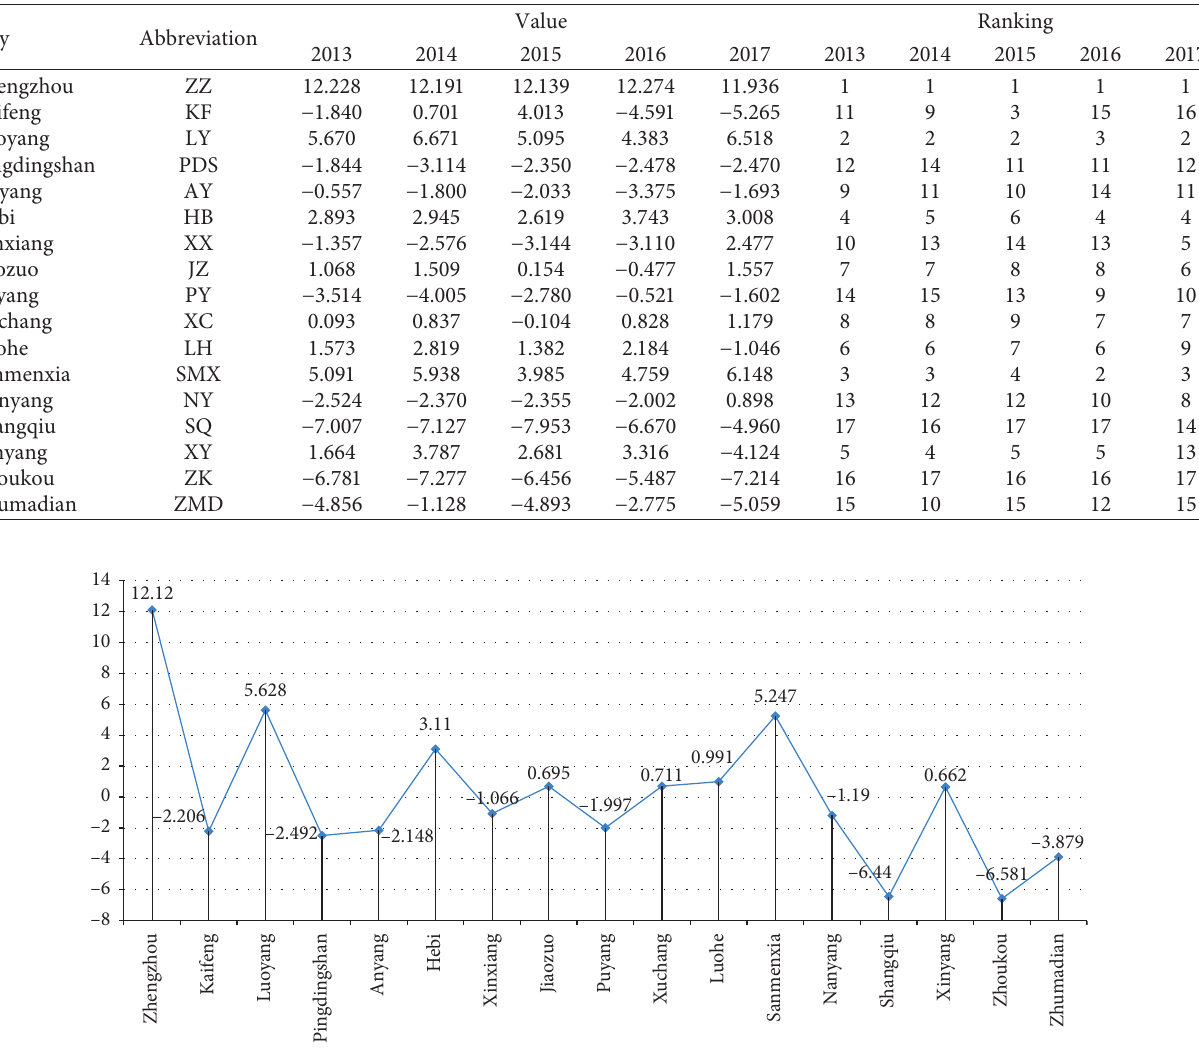
Figure 3: The comparison of the sustainability of cities in Henan Province. Table 4: The sustainability evaluation value and ranking of each city in the economic dimension. Value Ranking City